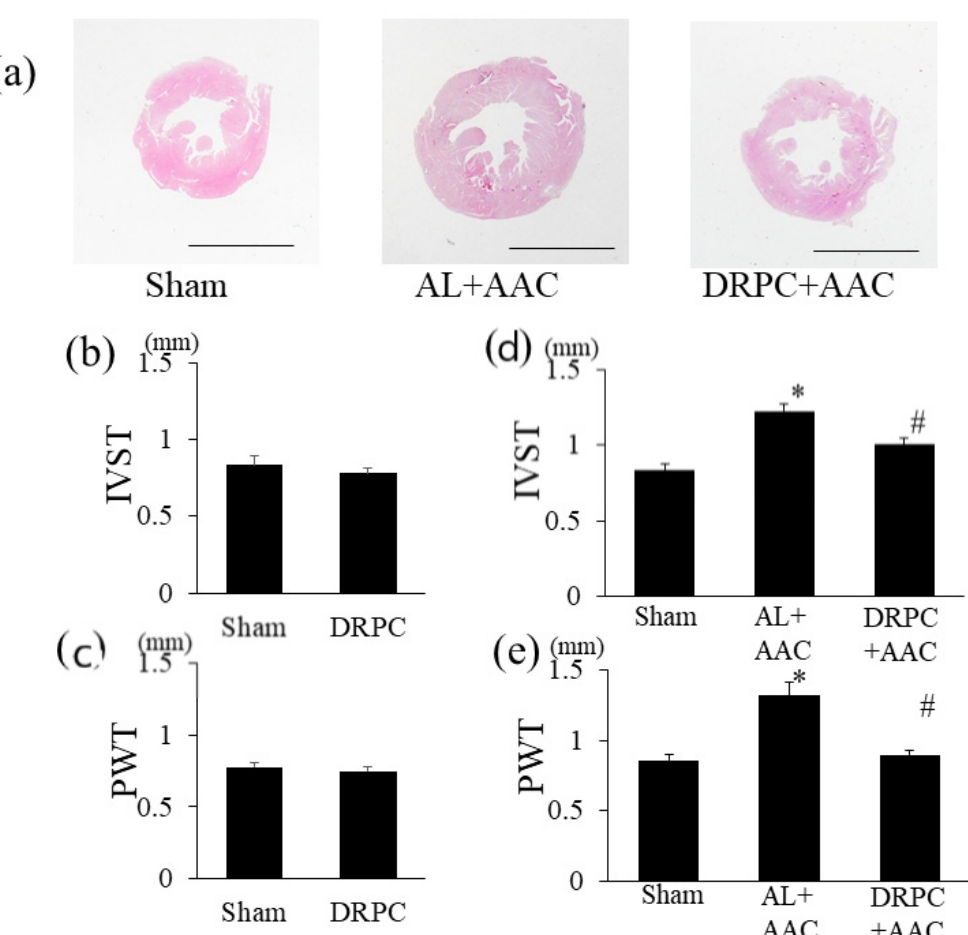
Figure 2. Effects of dietary restriction preconditioning on pressure overload-induced left ventricular wall thickening. ( a ) Representative low-power photomicrographs of hematoxylin & eosin-stained transverse left ventricular sections. Bars indicate 3 mm. Thicknesses of the interventricular septum (IVST) and the posterior wall (PWT) of the left ventricle before ( b, c ) and 2 weeks after surgery ( d, e ) (before surgery, Sham: n = 4, DRPC: n = 4, after surgery, Sham: n = 5, AL+AAC: n = 5, DRPC+AAC: n = 5). * p < 0.01 versus Sham. # p < 0.01 versus AL+AAC.